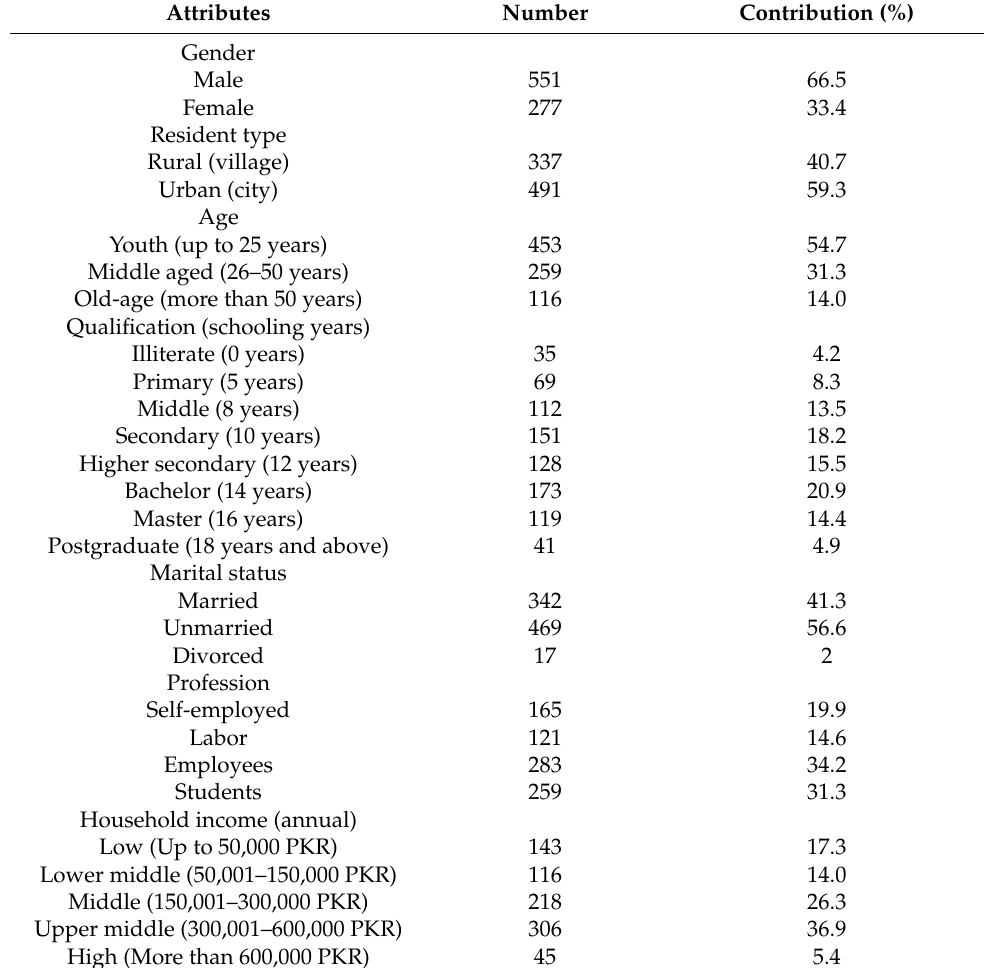
Table 1. Attributive profiles of the